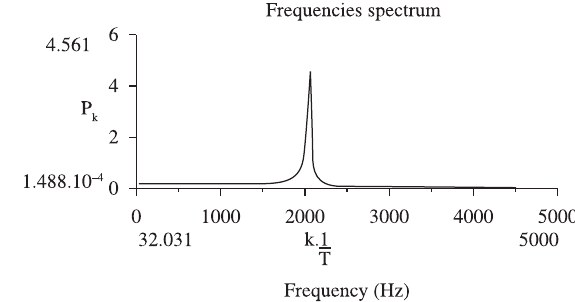
Figure 4. Mean amplitudes in function of time for each Probe-sample.